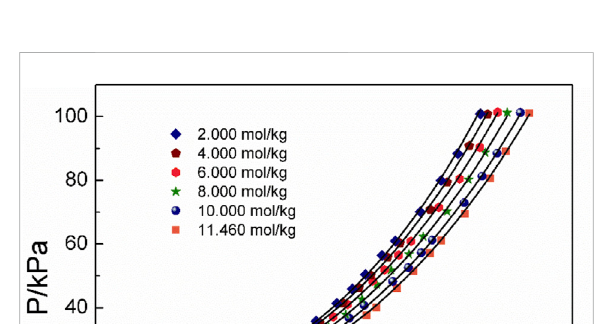
FIGURE 5 Correlation of experimental VLE data for the L -serine aqueous solution. Symbols represent experimental data (this work), and lines represent the correlation of the model.